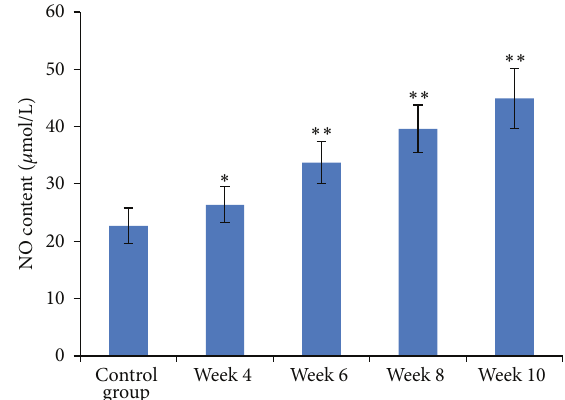
Figure 3: Measurement of NO content in portal venous blood. Results are expressed as means ± SD, ∗ 𝑃 < 0.05 and ∗∗ 𝑃 < 0.01 versus the control group.